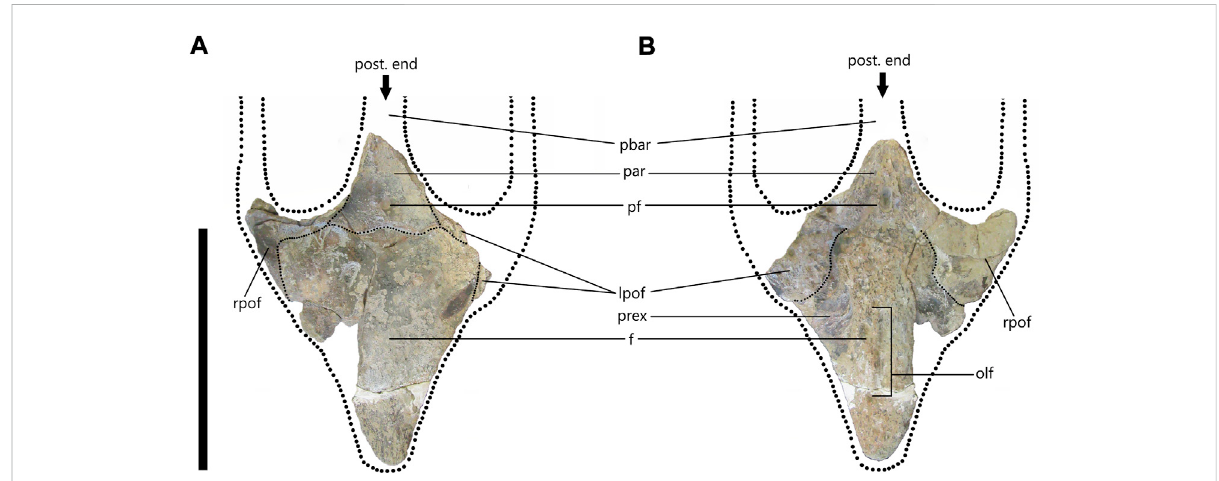
FIGURE 2 cf. Prognathodon (SAM-PK-5265) frontoparietalcomplex indorsal (A) and ventral (B) viewswith dottedlines toreconstructanteriorportions of parietal bar and postorbitofrontal rami. (A) Fine, dotted lines indicate sinusoidal suture with 5 alae between frontal and postorbitofrontals and parietals. (B) Fine,dottedlinesindicatesuturesbetweenfrontalandpostorbitofrontals.Abbreviations:frontal(f);leftpostorbitofrontal(lpof);olfactory tract (olf); parietal (par); parietal bar (pbar); pineal foramen (pf); prefrontal excavation (prex); right postorbitofrontal (rpof). Scale bar = 300 mm.